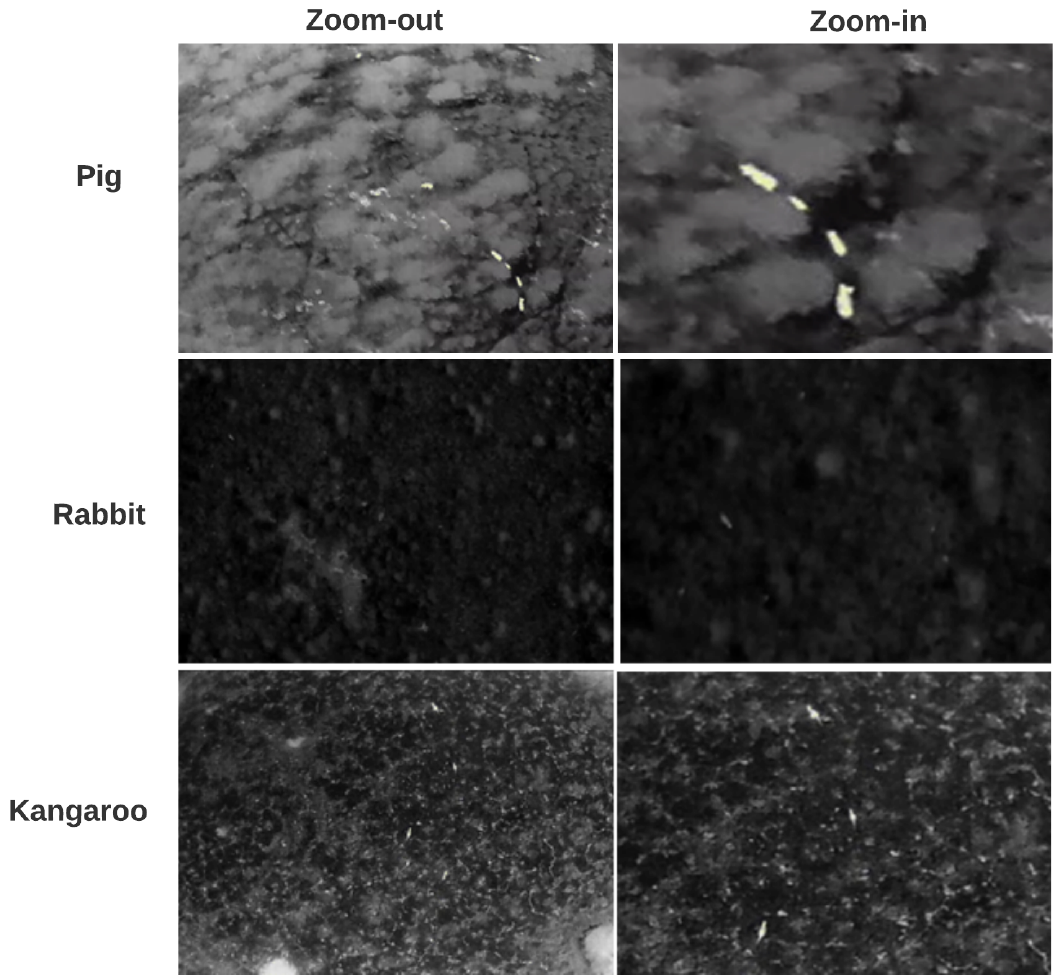
Figure 3. Dataset sample of zoom-in and